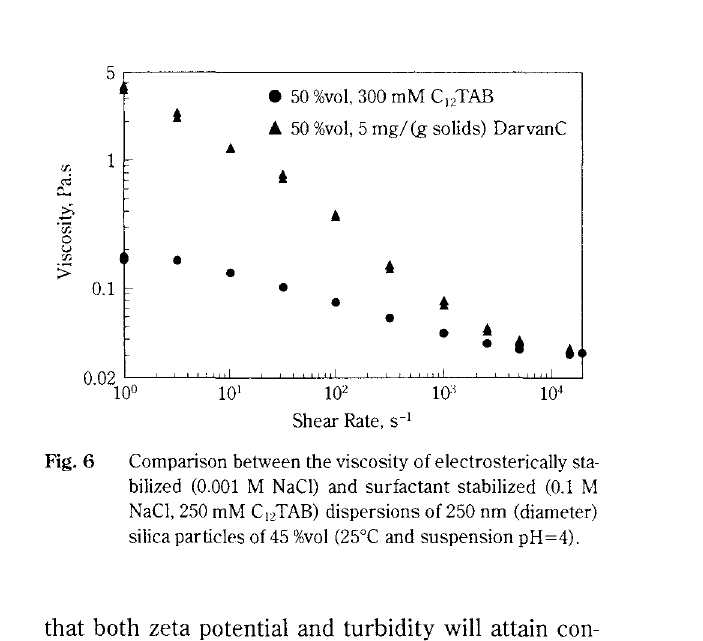
Comparison between the viscosity of electrosterically sta bilized (0.001 M NaCI) and surfactant stabilized (0.1 M NaCI, 250 mM C 12 TAB) dispersions of 250 nm (diameter) silica particles of 45 %vol (25°C and suspension